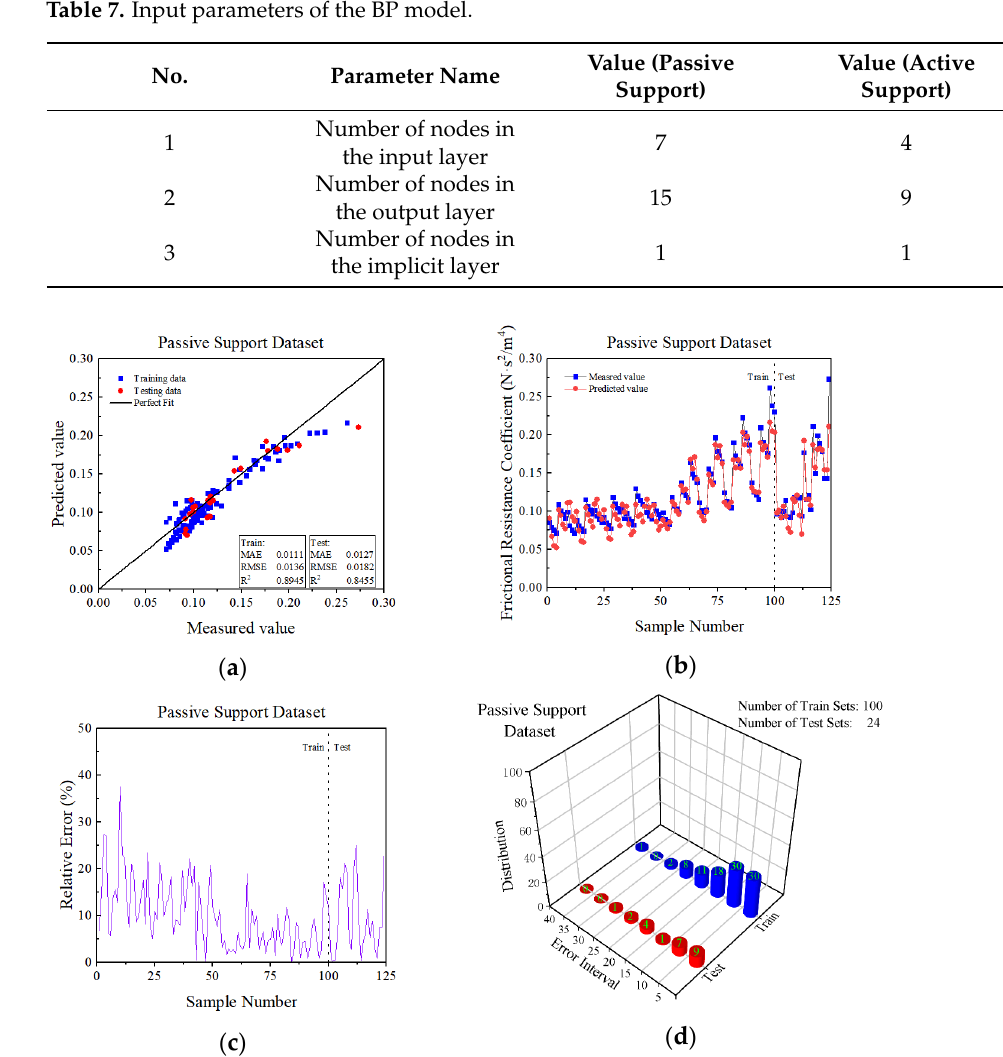
Figure 12. The passive support BP model prediction results. ( a ) Correlation evaluation of the measured and predicted values of α; ( b ) curves of the measured and predicted values of the samples; ( c ) sample prediction error curve; ( d ) sample error frequency distribution.